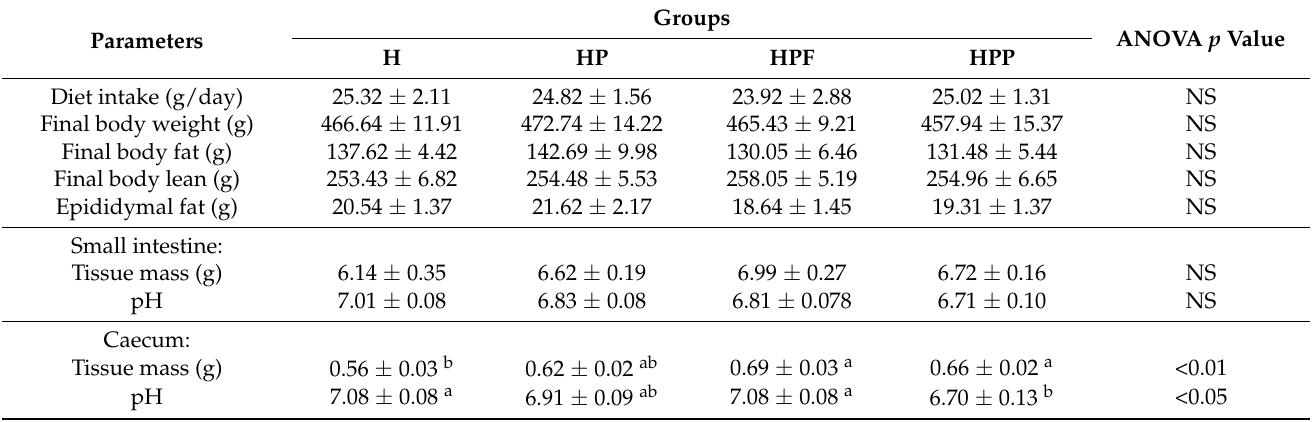
Table 2. Growth parameters and basic indicators of gastrointestinal tract function in the rats fed the experimental diets.